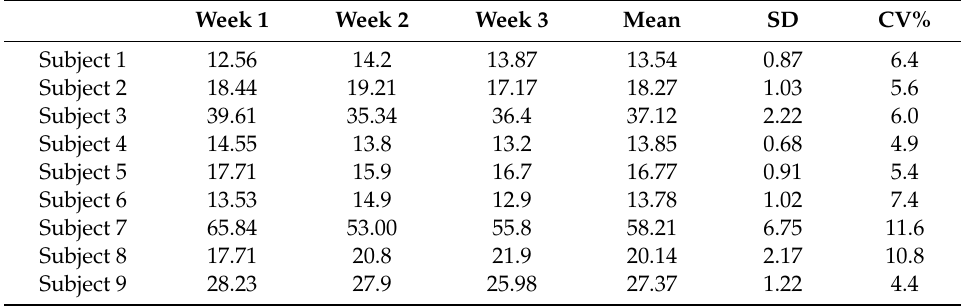
Table 3. Intra-assay coefficient variability (intra-assay CV) of PAOT-Skin Score ® calculated (7.0 ± 2.5%) from a population of nine healthy volunteers (Group IIb).